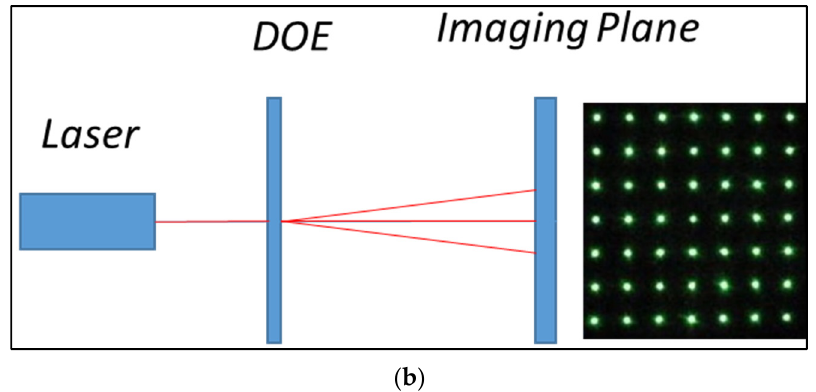
Figure 2. ( a ) Flowchart of DOE formation through phase retrieval. ϕ , A 0 are estimates of the image phase and amplitude respectively. The Fourier transform of image plane, A 0 e − i ϕ is used to recover the output plane, Ae − i φ . The output plane calculated from the diffraction pattern is estimated to the desired Fourier transform output intensity, A m e − i φ . The estimate of the Fourier transform is then inverse Fourier transformed to A s e − i ϕ . The IFT signal must is changed if the new estimate of the transform does not satisfies the desired output constraints then the whole process is repeated until both the Fourier constraint and output constraint are satisfied. ( b ) Schematic of phase pattern formation with DOE.